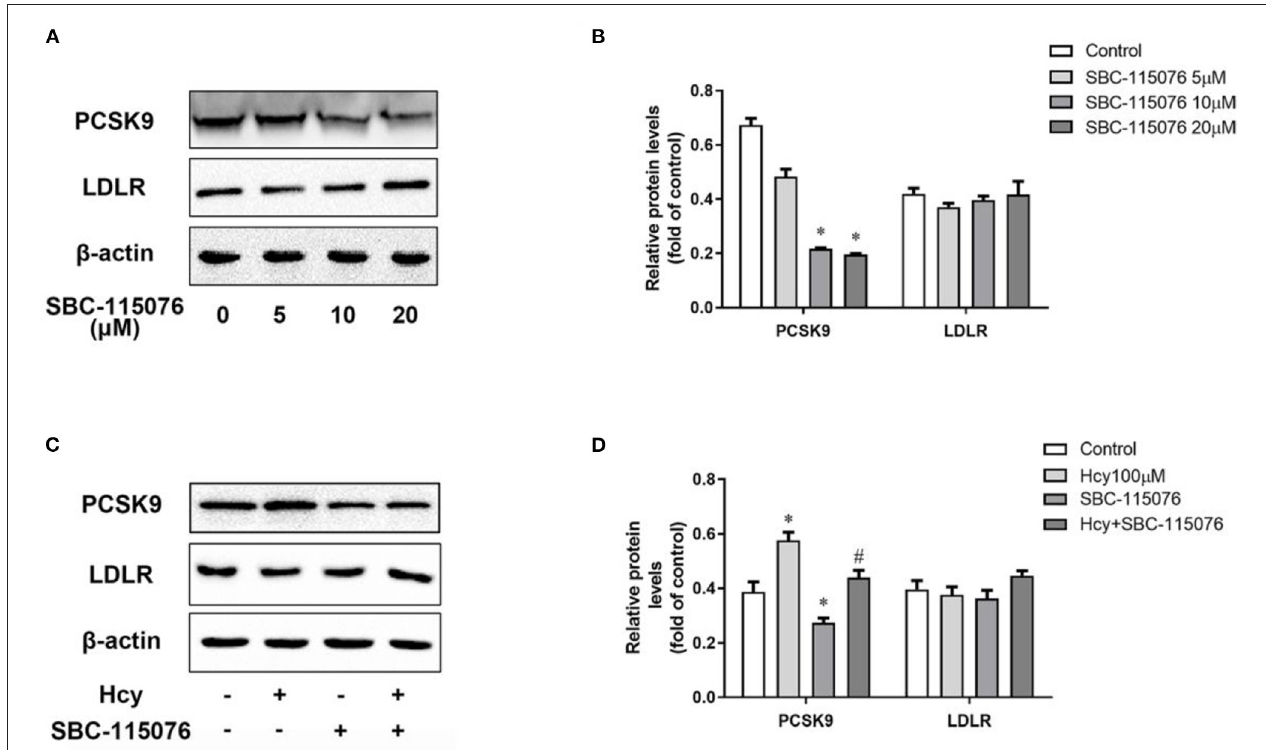
FIGURE 2 | SBC-115076 reversed the up-regulation of PCSK9 caused by Hcy. Protein levels of PCSK9 and LDLR were determined by western blot analysis with 5, 10, and 20 µ mol/L SBC-115076 for 24h (A,B) in THP-1 macrophages. Then cells were co-incubated with 100 µ mol/L Hcy and 20 µ mol/L SBC-115076 for 24h. Protein levels of PCSK9 and LDLR were determined (C,D) . Data represent mean ± standard error of the mean (SEM). Each experiment was performed three times. * p < 0.05 vs. the control group(Hcy 0 µ mol/L, which refers to incubation with PBS only). # p < 0.05 vs. Hcy group(Hcy 100 µ mol/L). Hcy,